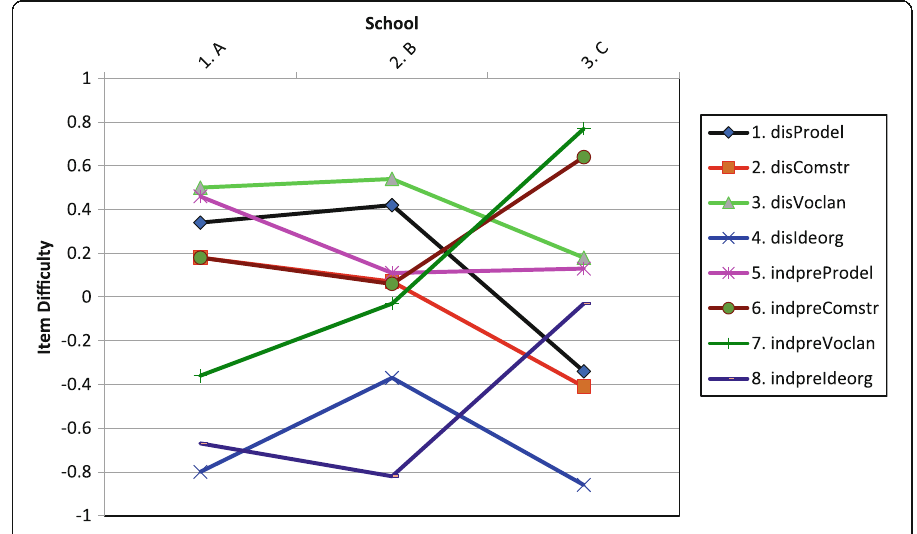
Fig. 1 Item difficulty estimates for the three